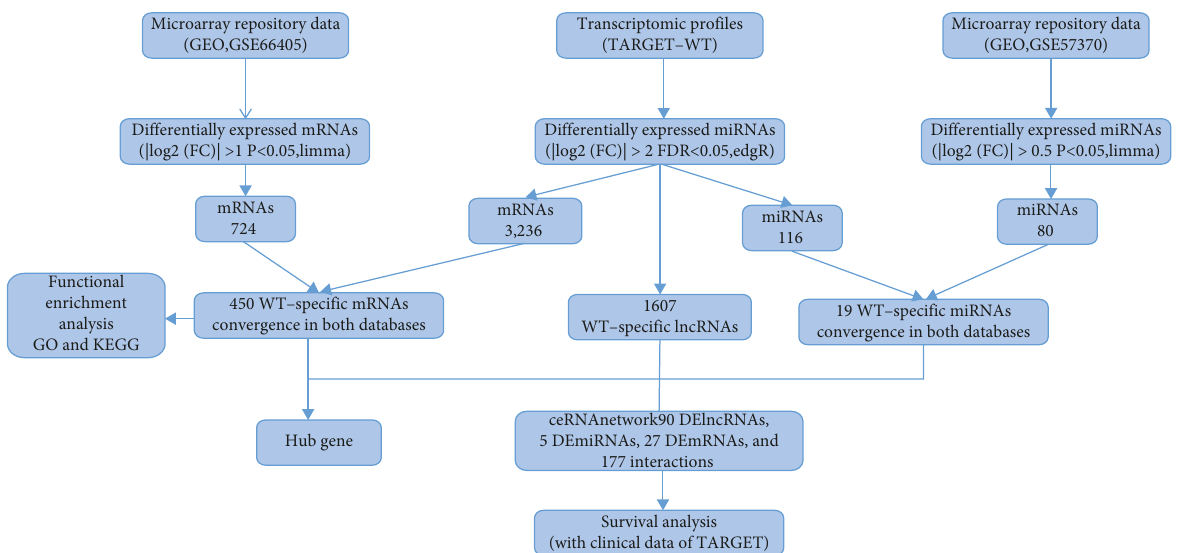
Figure 1: Flow diagram of the